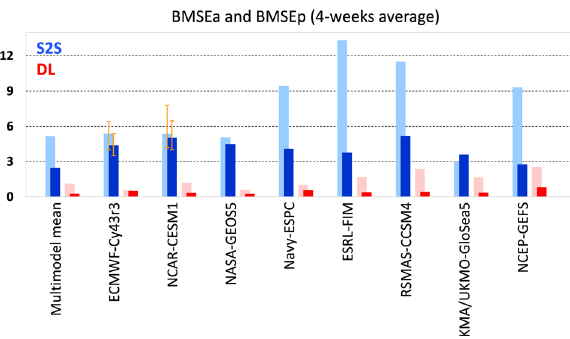
Fig. 3 Averaged forecast errors in individual models. Bivariate root-mean- squared amplitude error (BMSEa) (darker colours) and phase error (BMSEp) (lighter colours) for Subseasonal-to-seasonal (S2S) reforecasts (blue) and Deep learning (DL)-corrections (red) averaged over 4 weeks and eight phases shown in Fig. 2, Supplementary Figs. 3 and 4. For ECMWF-Cy43r3 and NCAR-CESM1, the orange error bar denotes the 95% con fi dence interval based on the bootstrap method. NCEP-GEFS = National